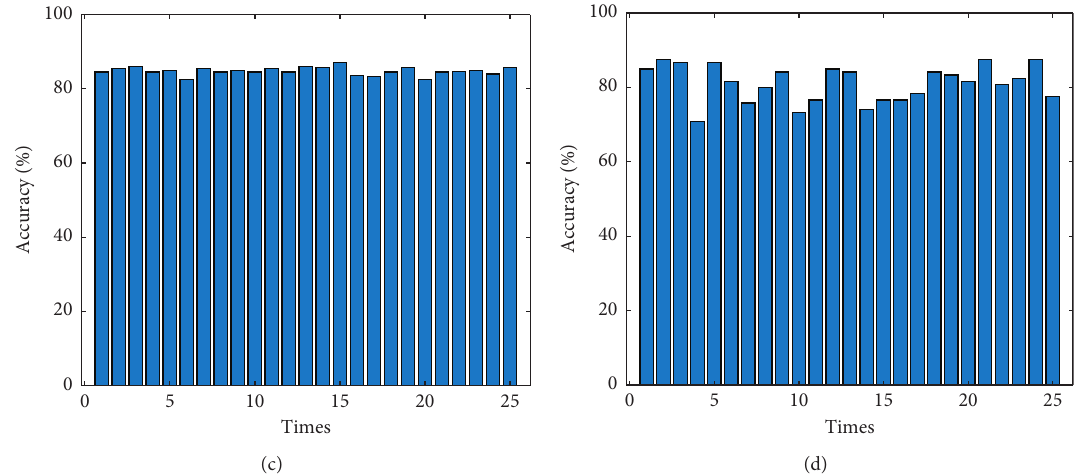
Figure 10: Accuracy of different methods. (a) The proposed method. (b) DBN set by experience. (c) Shallow probability network. (d) Traditional fault diagnosis